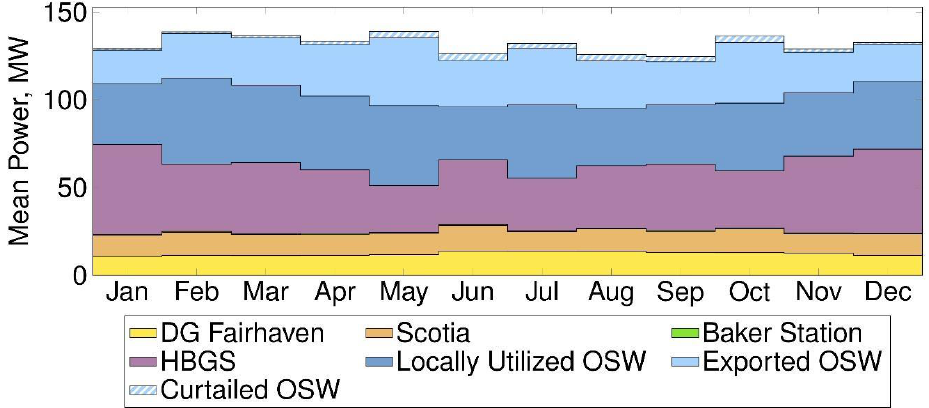
Figure 14. Monthly electricity generation by source to meet Humboldt County’s projected 2030 load profile with addition of a 48-MW offshore wind farm.